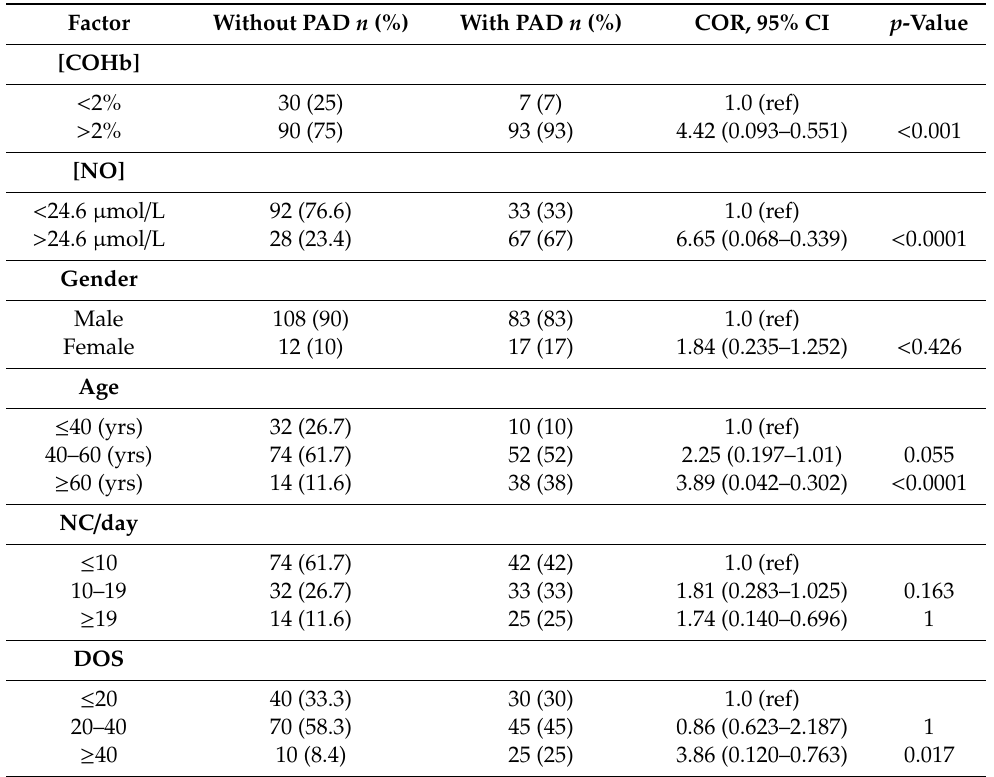
Table 3. Bivariate logistic regression analysis of the association between both COHb and NO with the presence of PAD.